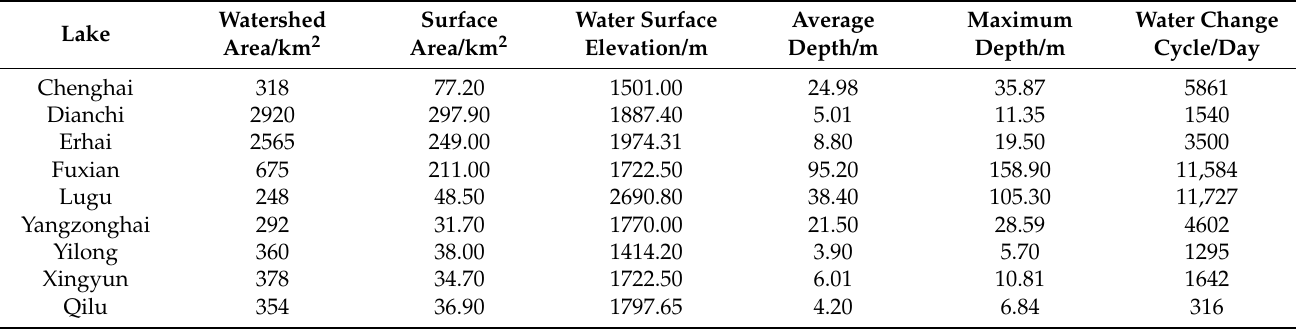
Figure 1. A map showing the location of lakes in the study area. Table 1. Morphological parameters of the nine major lakes on the Yunnan